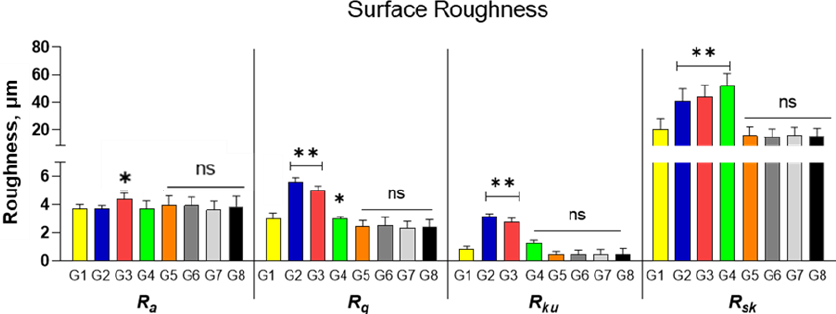
Figure 8. Surface roughness parameters (Ra, Rq, Rku and Rsk) of the study groups (mean, standard deviation). * p < 0.05, ** p < 0.01; n.s., Not